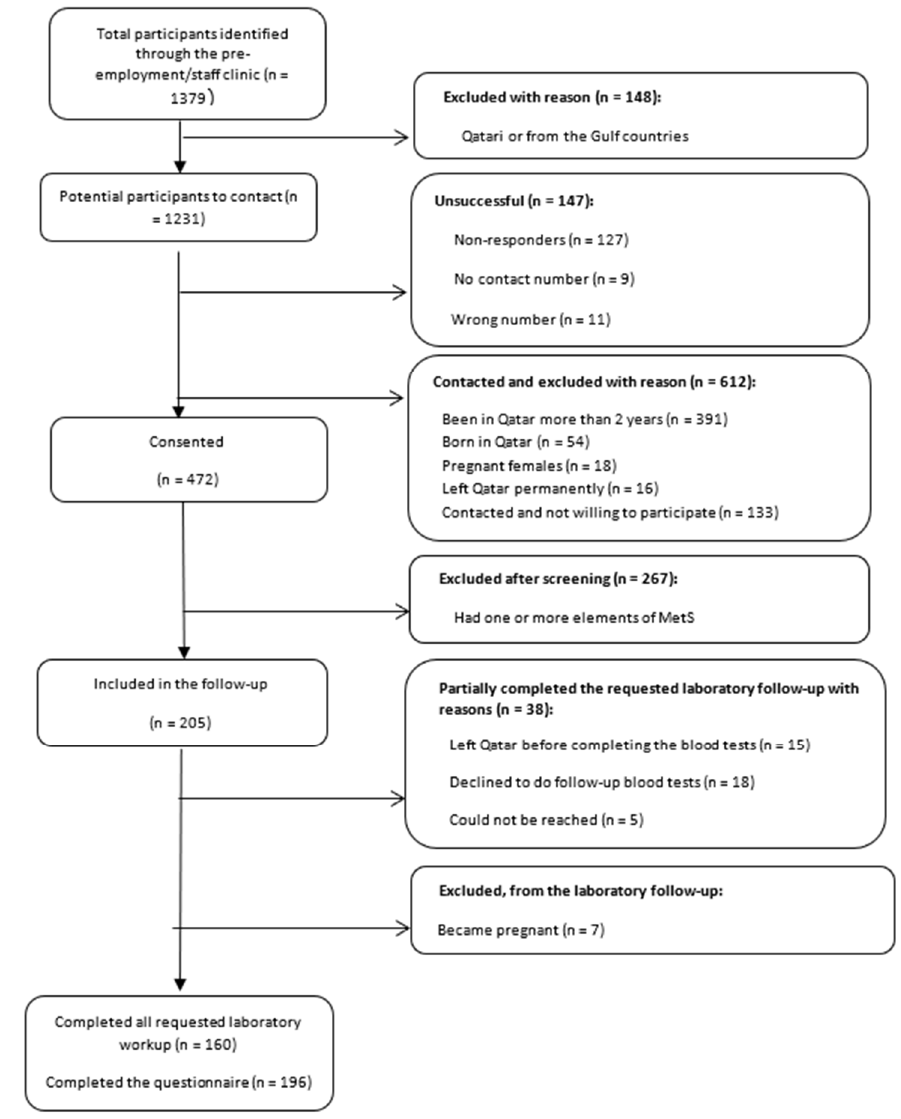
Figure 2. Participant flow at screening follow-up. Of the 205 MetS-free participants at baseline, 153 (74.6%) were males, and 166 (81.0%) came from Asia. The majority were healthcare providers, predominantly nurses ( n = 136, 66.3%; Table 2).